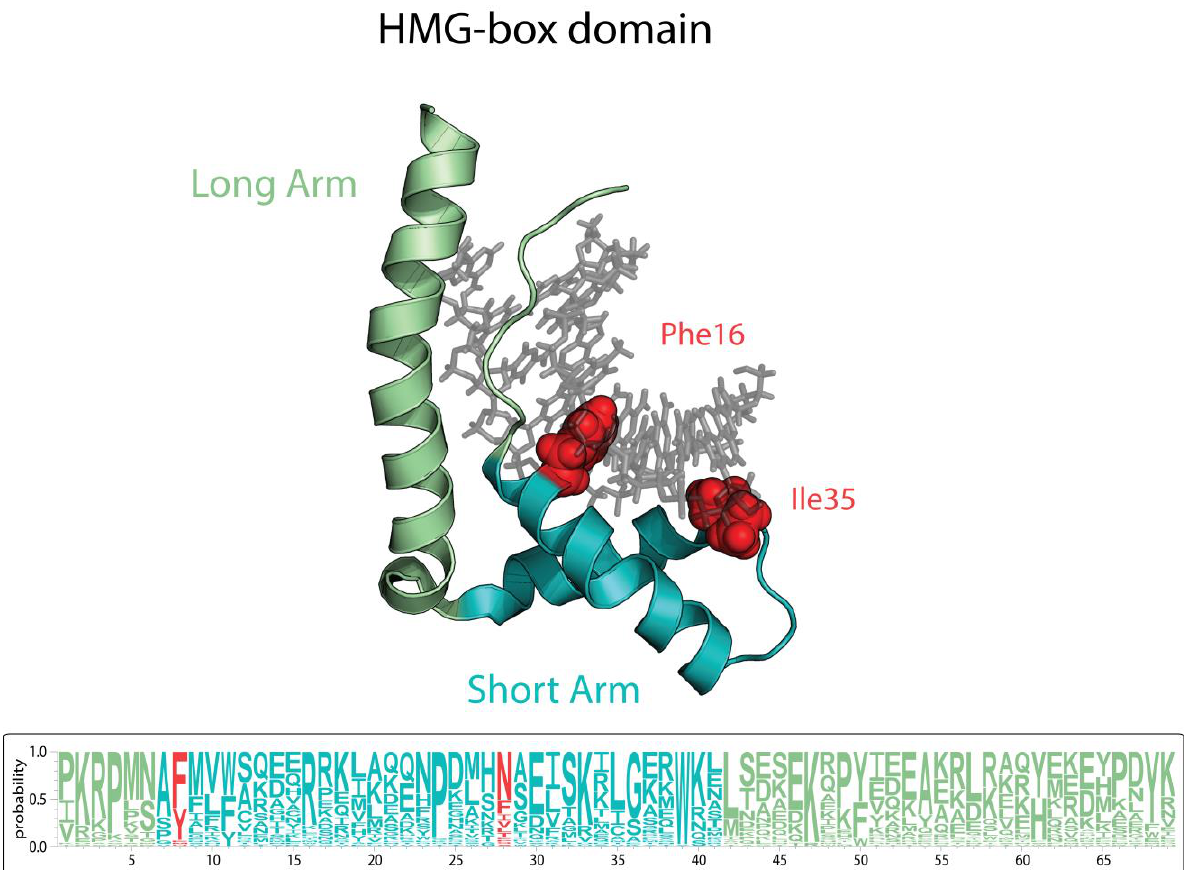
Figure 3. Structure of the HMG-box domain based on Hmgb1 protein structure PDBID: 2gzk and alignments of HMGB proteins. The amino acid frequency for each position of the HMG-box domain is represented in Logo format based on the multiple alignment available in Supplementary File S1. Amino acid sidechains that intercalate between the DNA base steps to induce the DNA kinks are indicated in red.